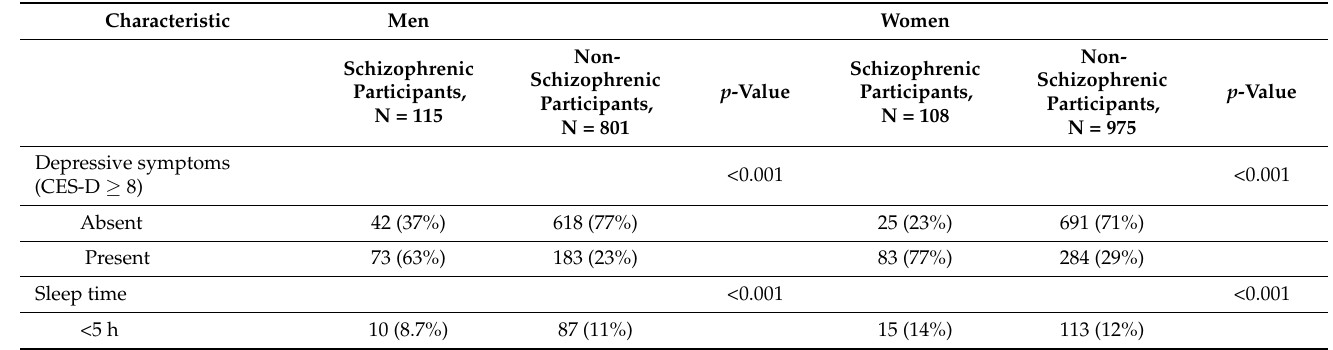
Table 3. Psychiatric comorbidities of participants with schizophrenia and participants without schizophrenia according to sex.